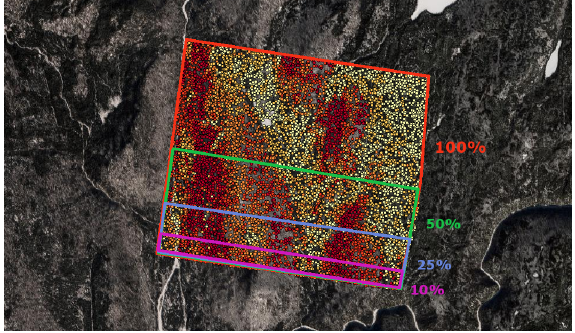
Figure 25. Areas Extent to select Learning